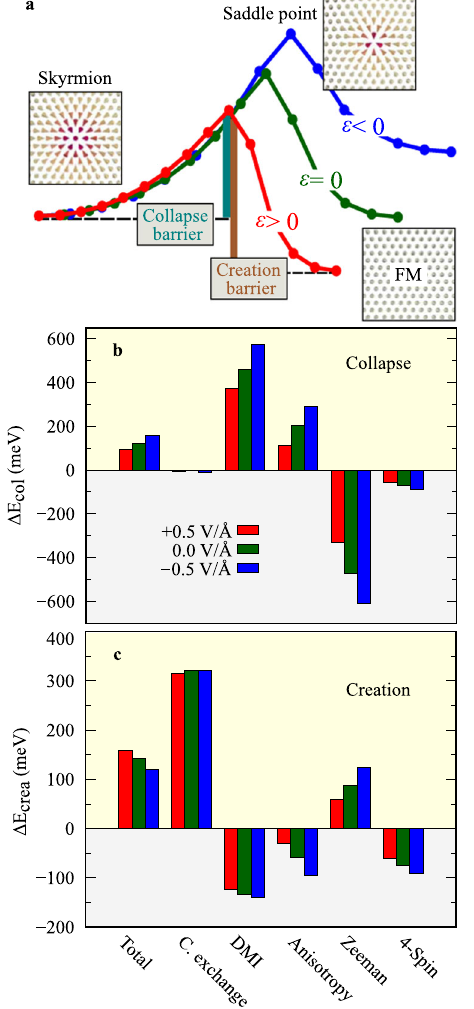
Fig. 5 Minimum energy path, collapse, and creation barriers at zero and fi nite electric fi elds. a Minimum energy paths (MEP) from the initial (skyrmion) to the fi nal (FM) state in Fe/Rh/Re(0001) at B = 3 T for zero and two fi nite electric fi elds ( E ¼ ±0.5 V/ Å ). The energy difference between the saddle point and the skyrmion (FM) state de fi nes the collapse (creation) barrier. Total and individual energy contributions at B = 3 T for b the collapse barrier and c for the creation barrier. For energy decomposition of the full MEP, see Supplementary Fig. 8. Combined exchange (C. exchange) indicates the sum of pair-wise exchange, biquadratic, and three-site four spin interactions. The four-site four spin interaction is denoted as 4-Spin for brevity. The electric fi elds E ¼ + 0.5 V/ Å , 0 V/ Å , and − 0.5 V/ Å are shown as red, green, and blue,